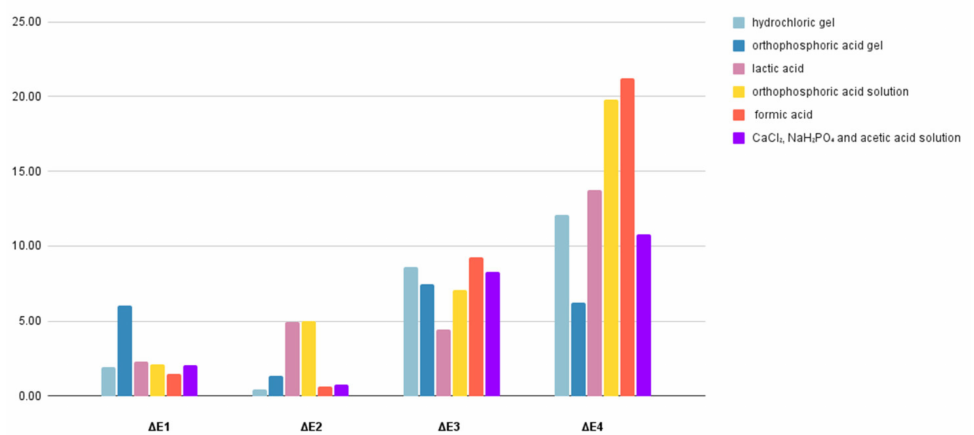
Figure 7. ∆ E values for the acidic solutions used.